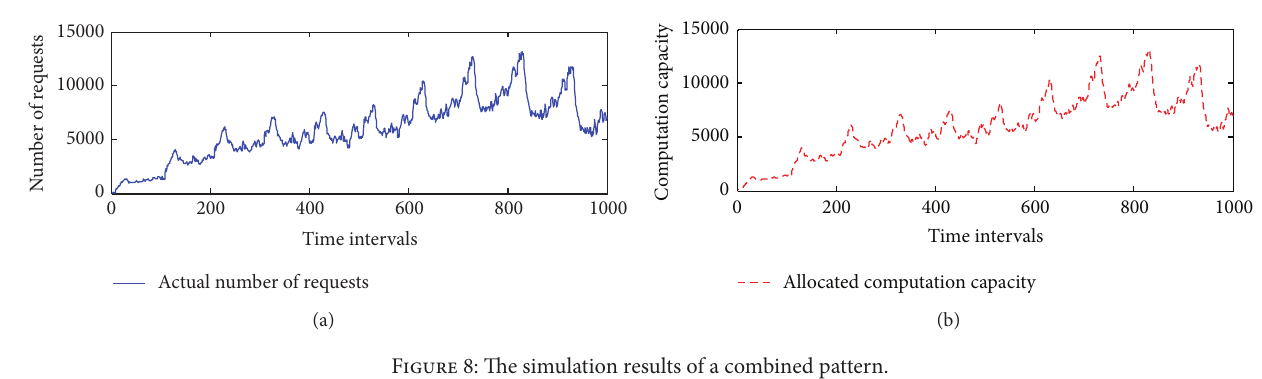
Figure 8: The simulation results of a combined pattern.